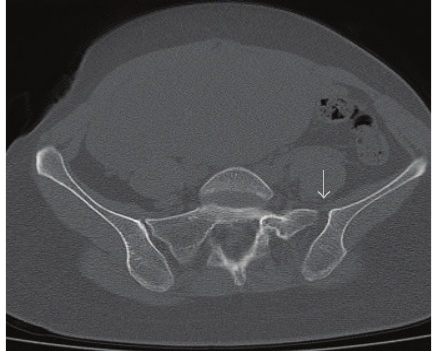
Figure 2: Computed tomography images demonstrating widening of the left anterior sacroiliac